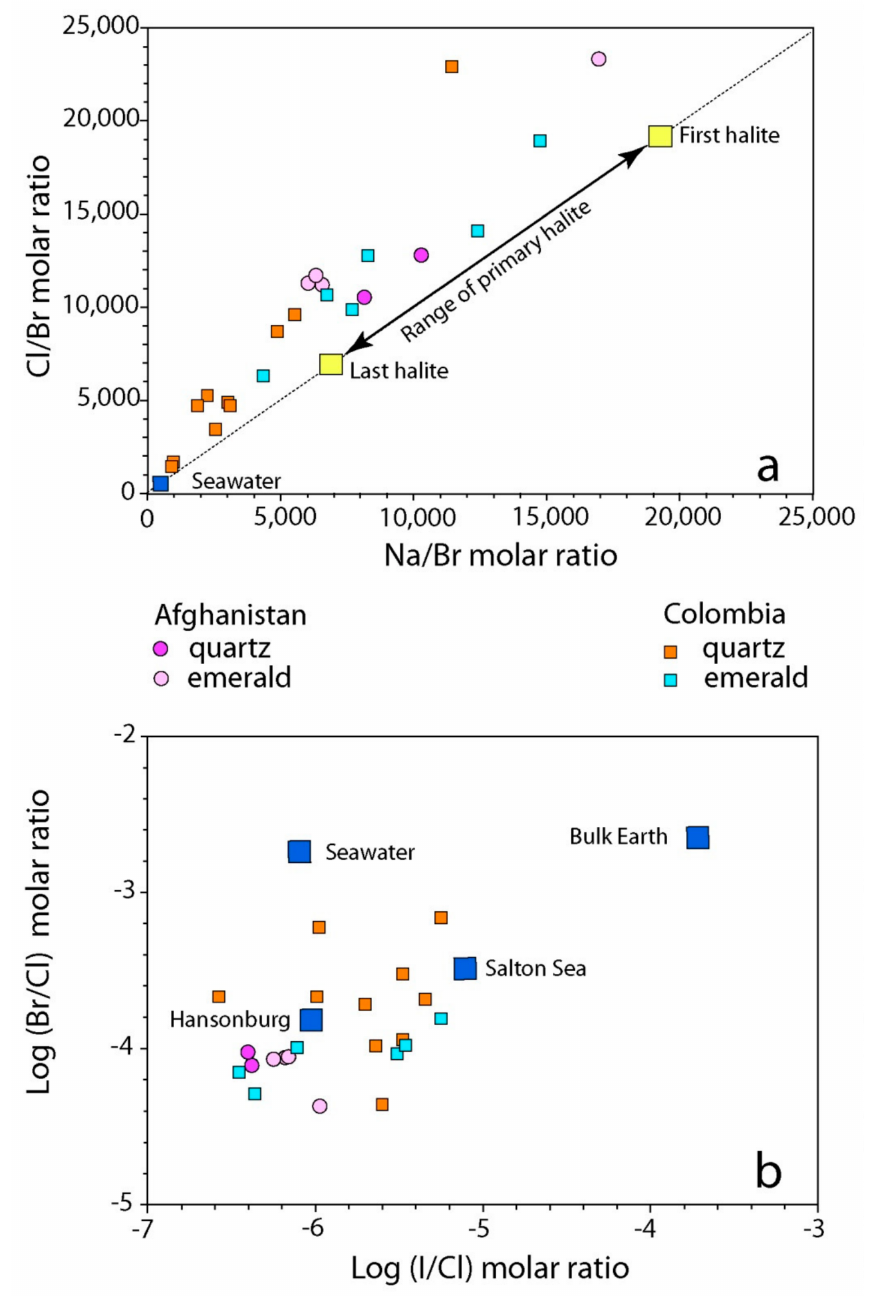
Figure 34. Origin of salinity in the emerald and quartz brines from Colombia and Afghanistan: ( a ) Analyses of the fluid inclusions from both emerald and quartz show a wide range of Na/Br and Cl/Br molar ratios that are much greater than those of primary halite and indicate a substantial loss of Br, typical of recrystallised halite for both emerald deposits; ( b ) log(I/Cl) versus log(Br/Cl) molar ratios of Afghan and Colombian fluid inclusions, which are depleted in both Br and I, indicative of evaporites contribution to the fluids in emerald and quartz. They are compared with the composition of fluids where evaporites are known to be involved, such as for the Salton Sea geothermal brines [163] and Hansonburg